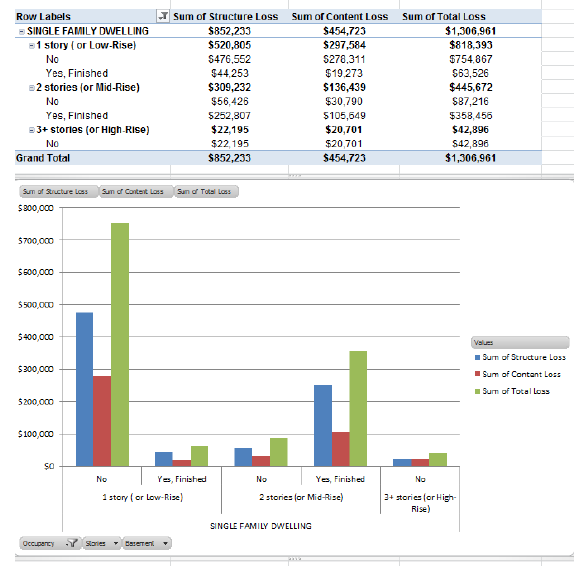
Figure 3. Pivot table and chart results